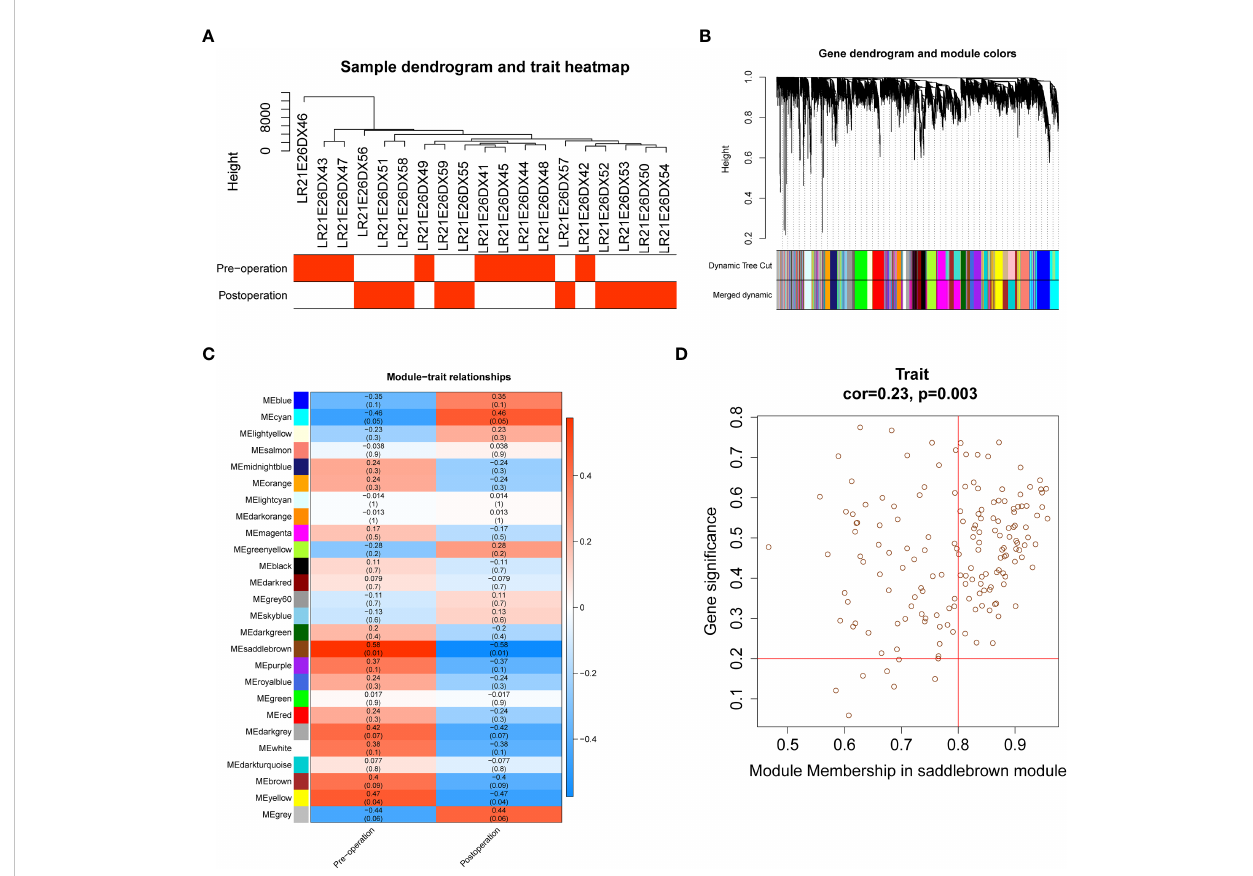
FIGURE 1 Identi fi cation of 91 hub genes related to obese patients treated with LSG by weighted gene coexpression network analysis (WGCNA). (A) Sample clustering with preoperative and postoperative external traits. (B) Dendrogram of the WGCNA modules. (C) The relationship between coexpression modules and external clinical traits and the saddle brown module was considered most relevant to clinical characteristics (cor = 0.58, p = 0.01). (D) Scatter plot of module eigengenes in the saddle brown module, the genes with |MM| > 0.8 and |GS| > 0.2 were selected as hub genes (cor = 0.23, p = 0.0.003). The horizontal axis represents the absolute value of the correlation between genes and modules, and the vertical axis represents the absolute value of the correlation between genes and